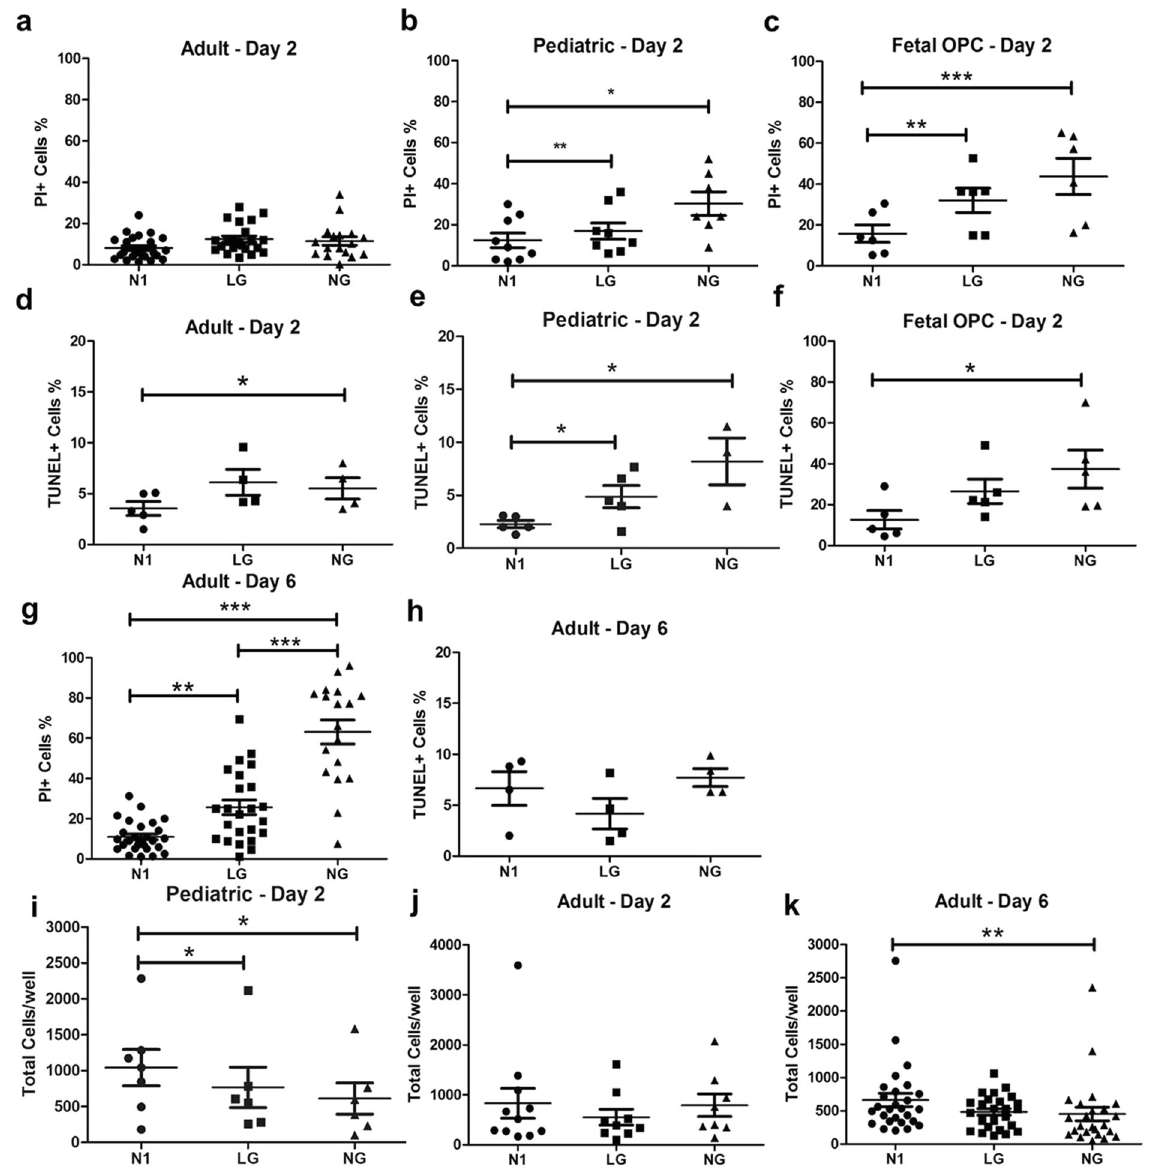
Fig. 1 In vitro cell death response of adult, pediatric and fetal samples derived human OLs to glucose deprivation conditions. a – c % PI + cells in 2-day cultures under N1, LG, and NG conditions. a Adult OLs show no signi fi cant increase in % PI + cells under LG/NG conditions. b Pediatric OLs show signi fi cant increase in % PI + cells under LG and more so under NG conditions. c Fetal O4 + cells show high levels of % PI + cells under LG and more so under NG conditions. d – f % TUNEL + cells in 2-day cultures under N1, LG, and NG conditions. d Adult OLs show no signi fi cant increase in %TUNEL + cells under LG/NG conditions. e Pediatric OLs show signi fi cant increase in %TUNEL + cells under NG condition but lower than % PI + cells. f Fetal O4 + cells show high levels of %TUNEL + cells comparable to % PI + cells under LG and NG conditions. g – h % PI + and TUNEL + adult OLs maintained in culture for 6 days. There are increased levels of % PI + cells under LG and NG conditions ( g ), while there is no signi fi cant increase in %TUNEL + cells ( h ). i – k Cell number/well in 2-day cultures under N1, LG, and NG conditions. Pediatric OLs at 2 days under LG and NG conditions and adult OLs at day 6 under NG conditions show signi fi cant decrease in cell numbers/well compared to N1 conditions. For some samples only LG or NG experimental conditions could be evaluated; all were compared to N1 control conditions. Each point in the graph corresponds to an independent biological sample. Mean ± SEM for each condition shown in the fi gure. Statistical signi fi cance was veri fi ed by Student ’ s t -test: *(<0.05), **(<0.01),